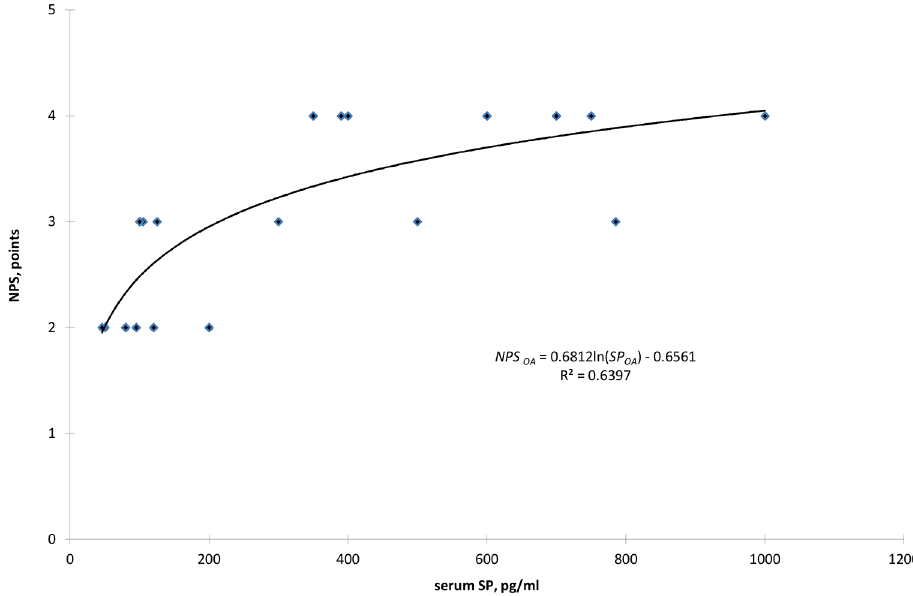
Fig 1. The relationship between NPS and the serum concentration of substance P (SP) for OA patients.